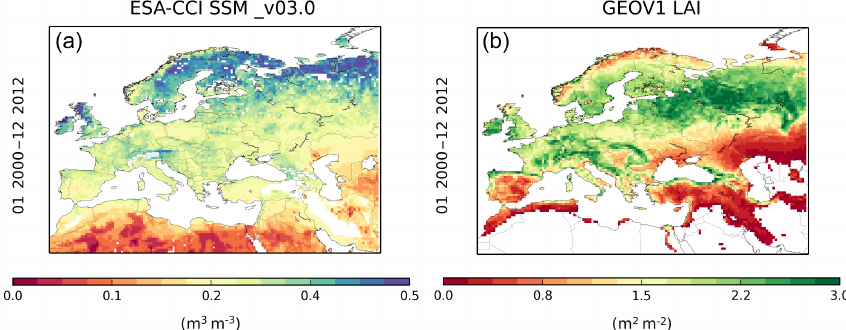
Figure 1. Averaged (a) surface soil moisture from the Climate Change Initiative project of ESA. (b) GEOV1 leaf area index from the Copernicus Global Land Service project (for pixels covered by more than 90% of vegetation) over